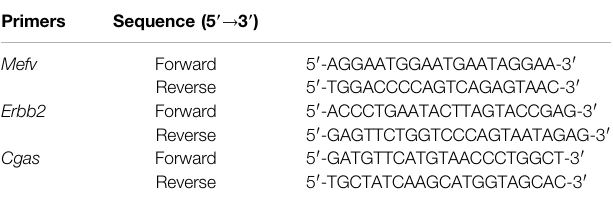
TABLE 2 | Sequences of primers used for